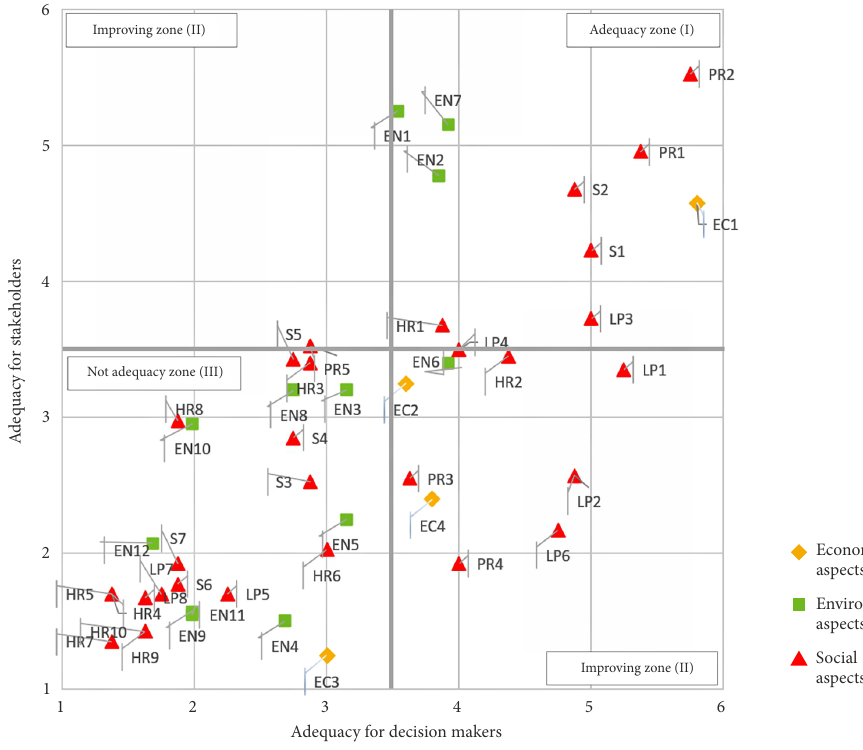
Figure 2. ACMO’s adequacy